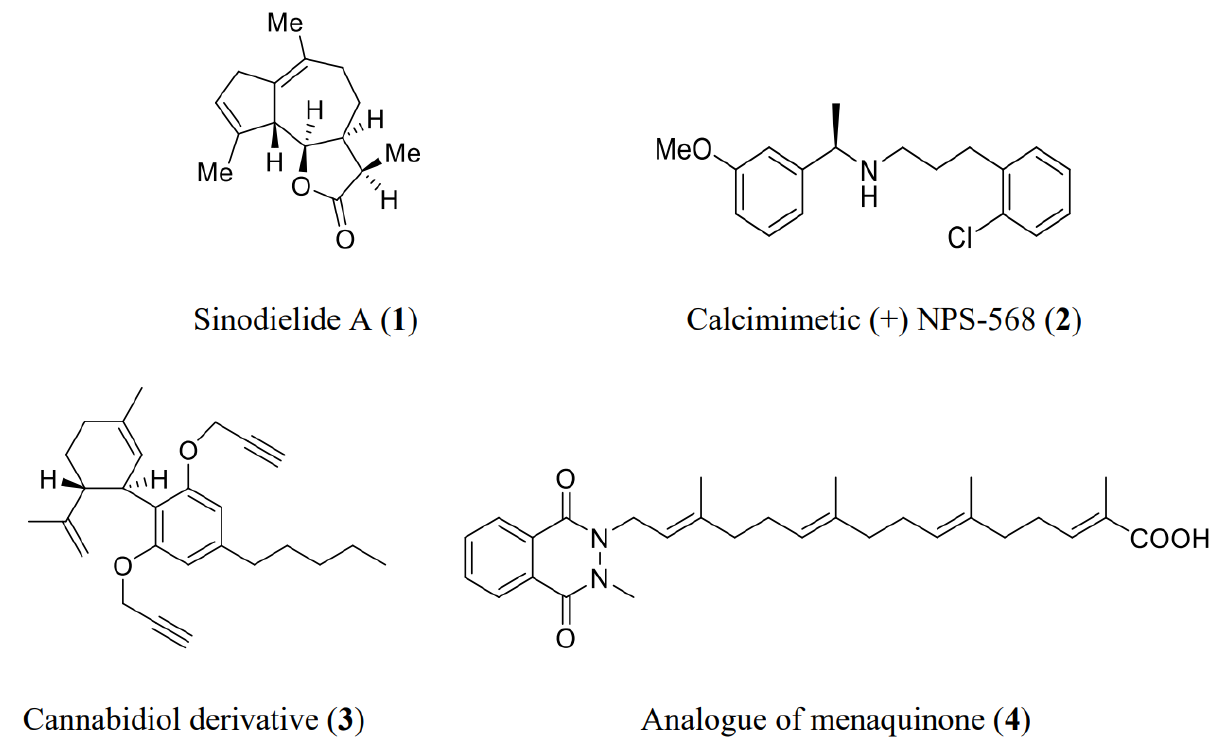
Figure 1. Structures of some biologically active natural compounds and synthetic derivatives.